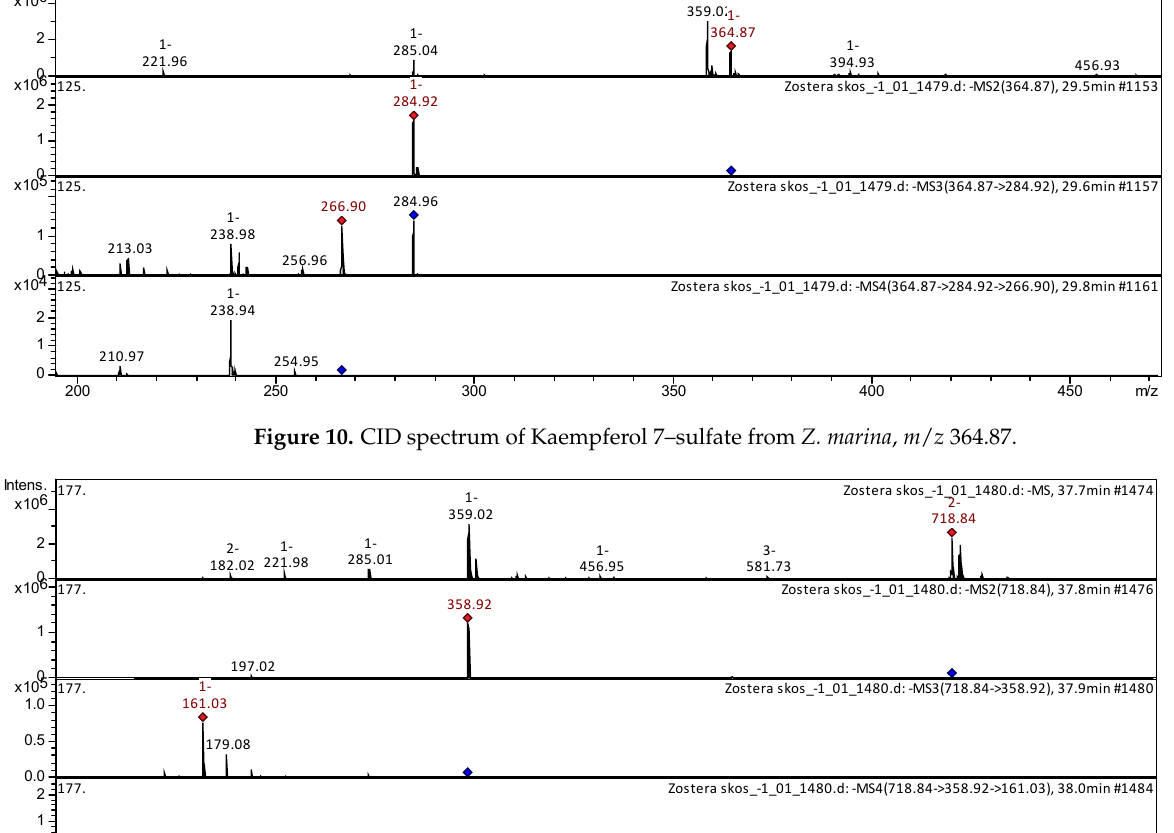
marina is shown in Figure 12. [M+H] + ion produced one fragment ion with m/z 144.99 (Fig-